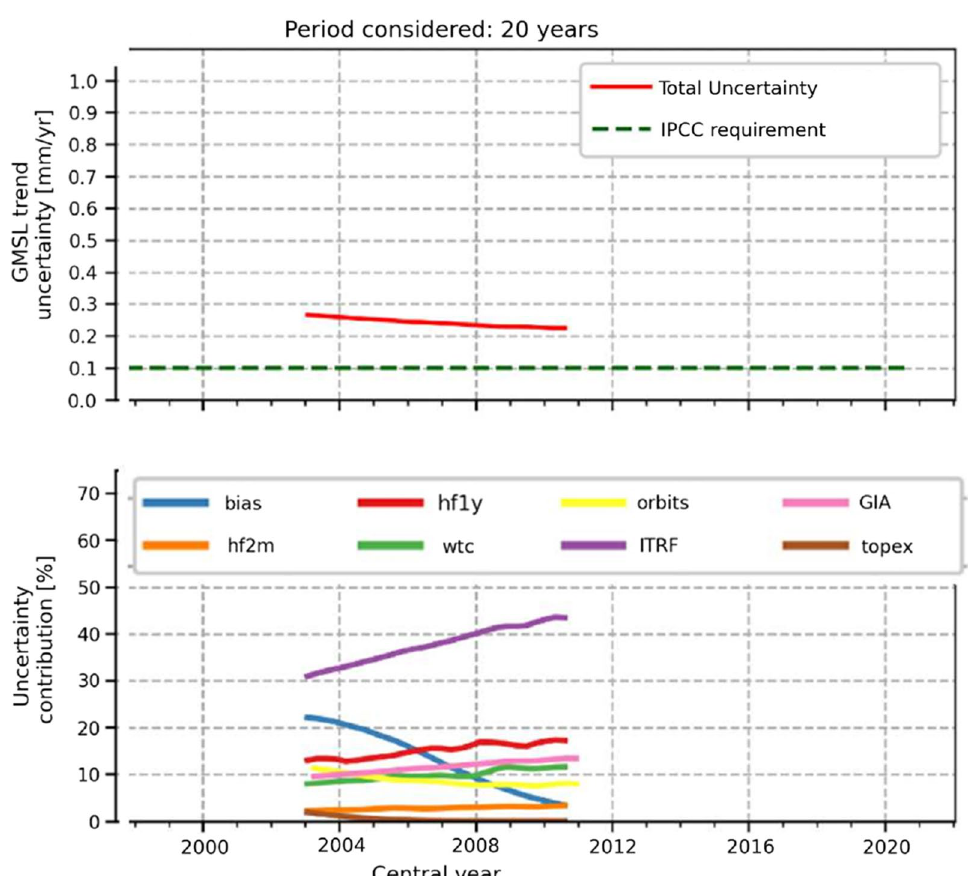
Fig. 4 Total uncertainty in the global mean sea level (GMSL) trend and individual contributions (Blazquez and Meyssignac 2022). The uncertainty coming from the International Terrestrial Reference Frame (ITRF) is clearly the major contribution, which implies a total uncertainty currently well over the Intergovernmental Panel on Climate Change (IPCC) requirement. Adapted from Ablain et al.